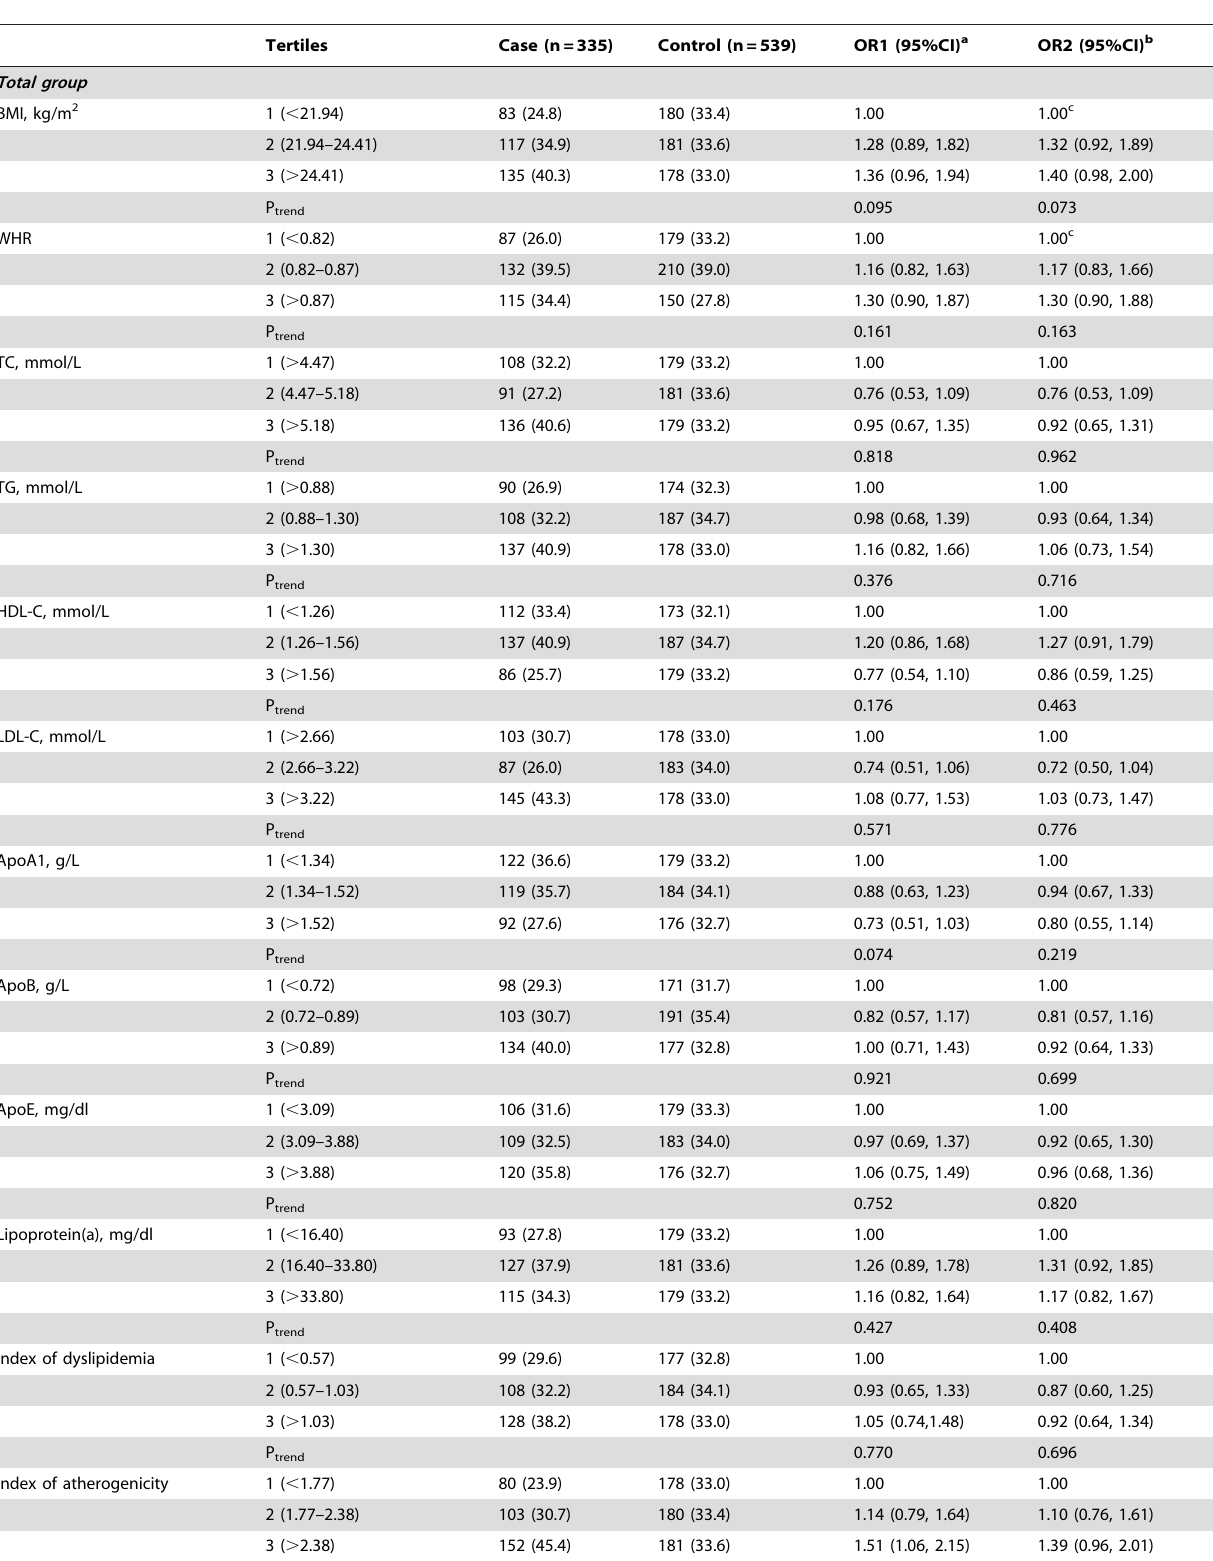
Table 2. Characteristics of cases with uterine fibroids and controls and odds ratios of uterine fibroids according to subclinical atherogenic and cardiovascular risk